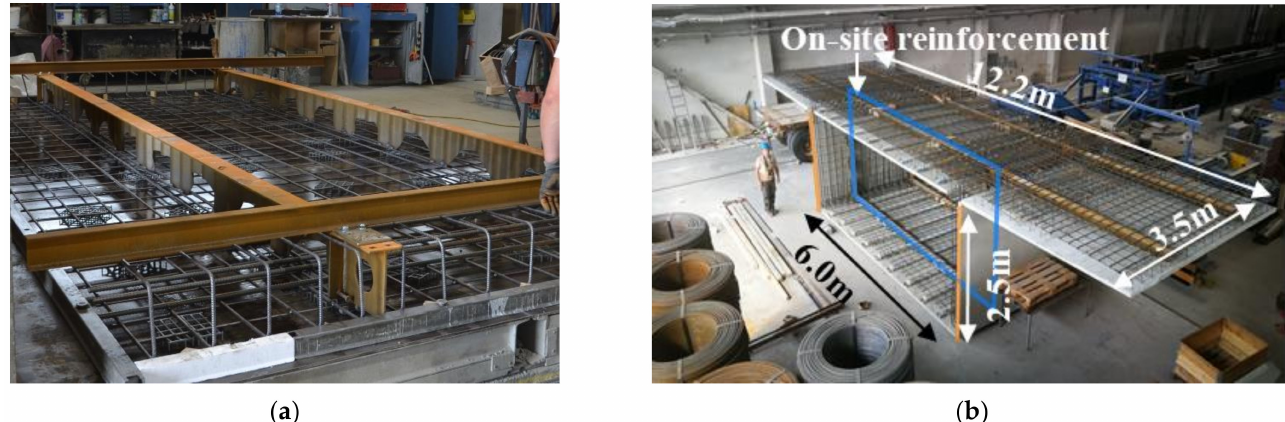
Figure 1. Construction of a lightweight bridge segment using thin-walled prefabricated elements with 70 mm thickness ( a ) corrugated steel web girders on a casting bed ( b ) prototype bridge segment with highlighted cross-frame in blue and highlighted surface for shear transmission in orange (taken from